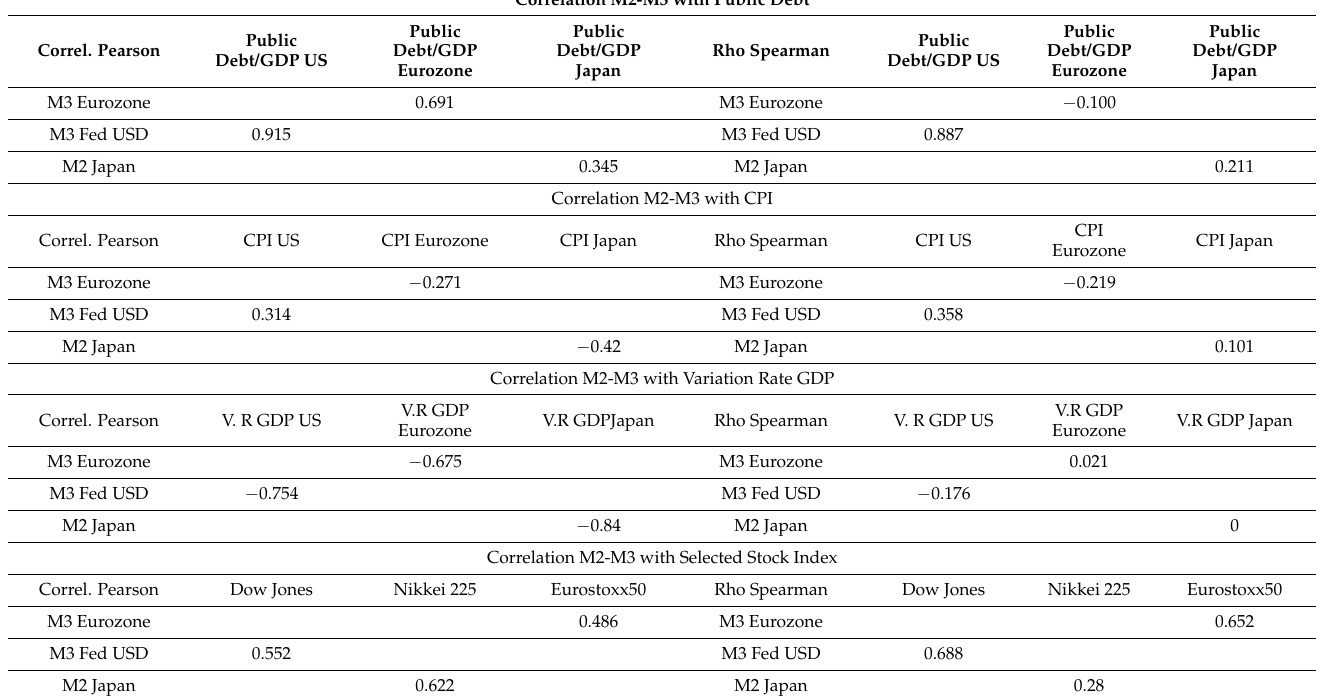
Table 2. Statistical correlation between M2–M3 and public debt, CPI, GDP growth rate and stock market